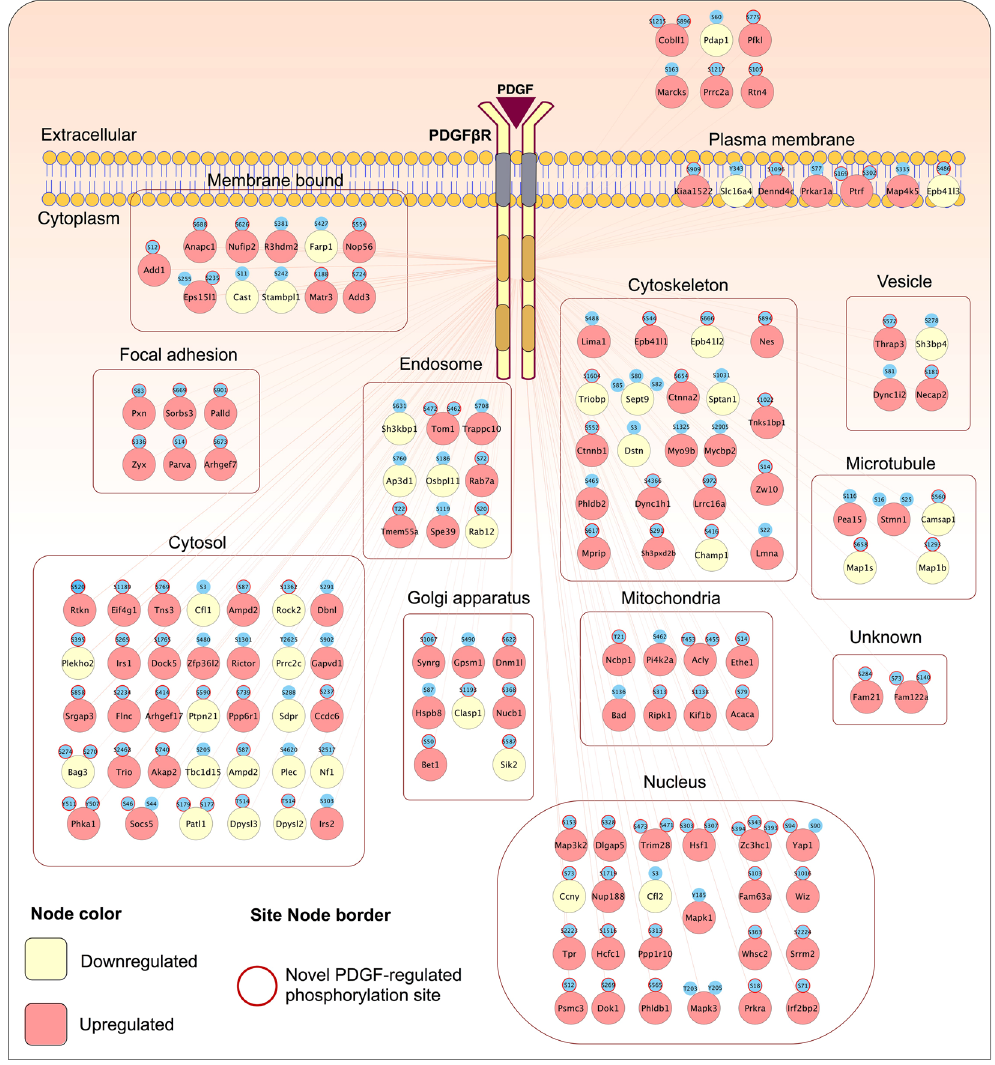
Figure 3. PDGF-regulated proteins and phosphosites. Proteins containing PDGF-regulated phosphosites were clustered according to their subcellular localisations as listed in the COMPARTMENTS database. PDGF- regulated phosphosites on each protein are shown in blue and those that are novel PDGF-regulated sites are bordered in